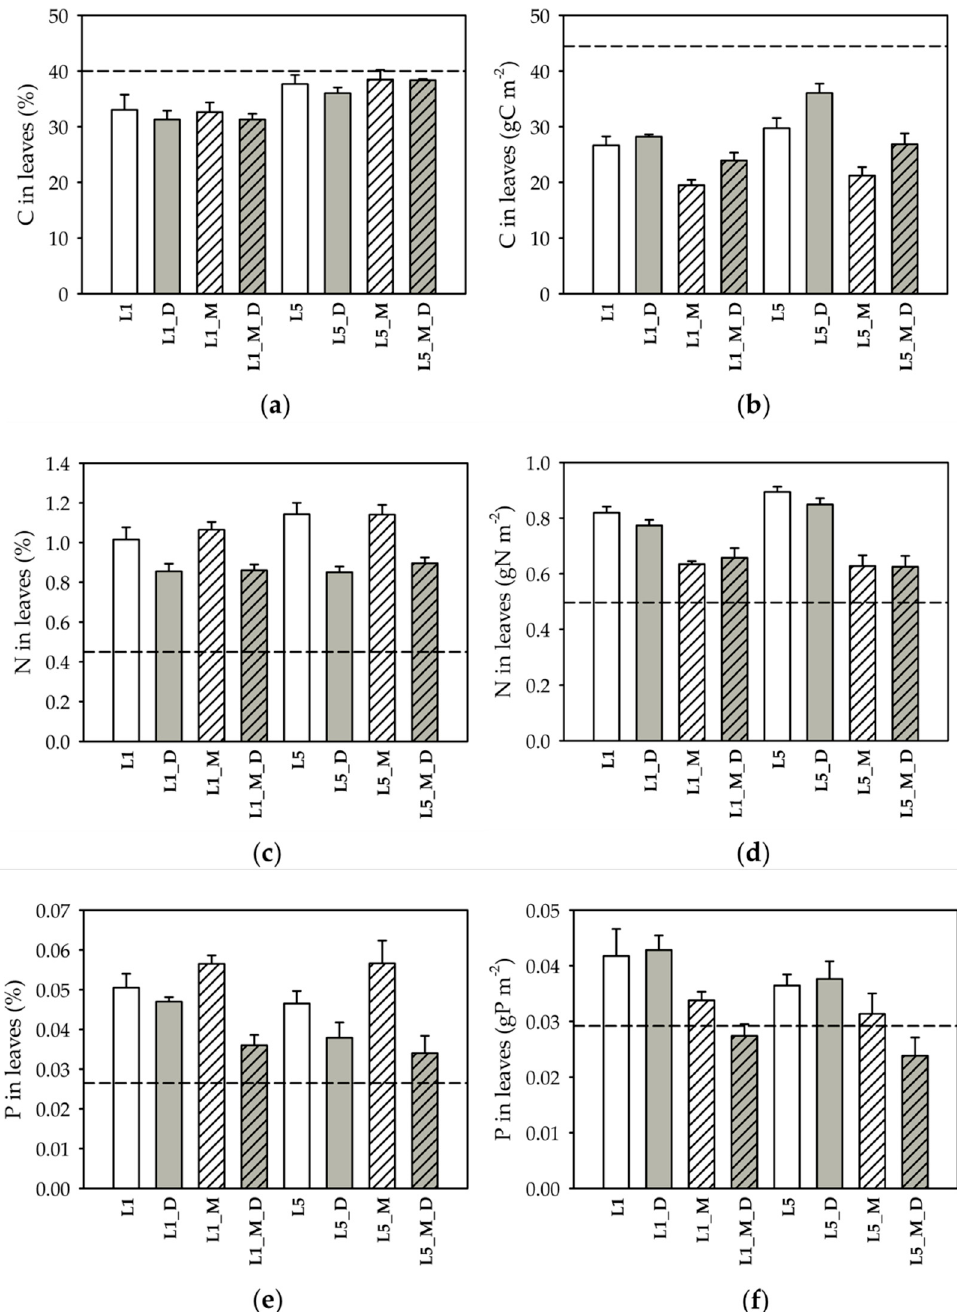
Figure 4. C, N and P percentage ( a , c , e ) and content ( b , d , f ) in the residual litter at the end of the experimental period. Mean ± standard error ( n = 5) are reported. White bars represent the permanently submerged condition, grey bars represent dried conditions and hatched bars represent conditions with macrofauna. The horizontal dashed line is the reference value of the average C, N, P percentage and content in leaves at the beginning of the experiment.